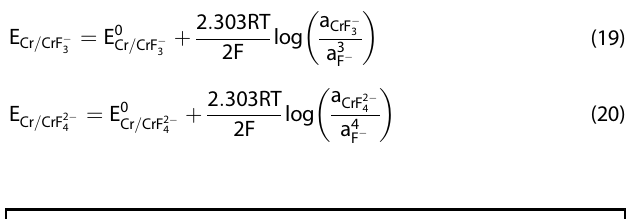
Table 1. Standard Gibbs free energy of formation ( Δ G o fl uoride and chromium- fl uoride compounds at 600 °C. Compound KF CrF 2 CrF 3 Ref.